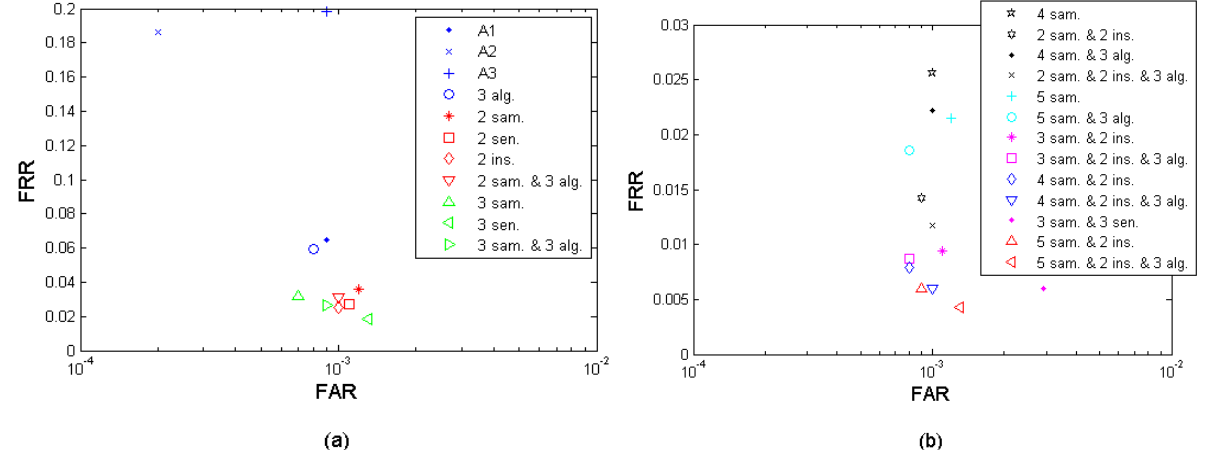
Figure 14. Fusion efficiency by “efficiency per presentation”. (“sample”, “algorithm”, “sensor”, and “instance” are abbreviated as “sam.”, “alg.”, “sen.”, and “ins.”, respectively)